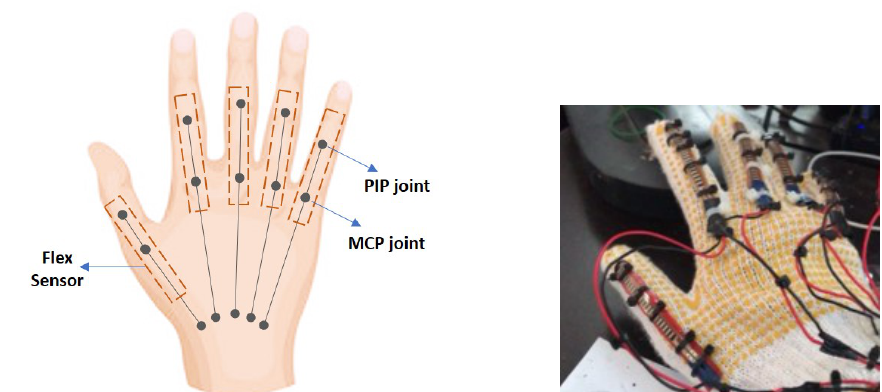
Figure 8. Positions of flex sensors with respect to the MCP and PIP joints ( left figure ); Flex sensors attached to the goniometric glove ( right figure